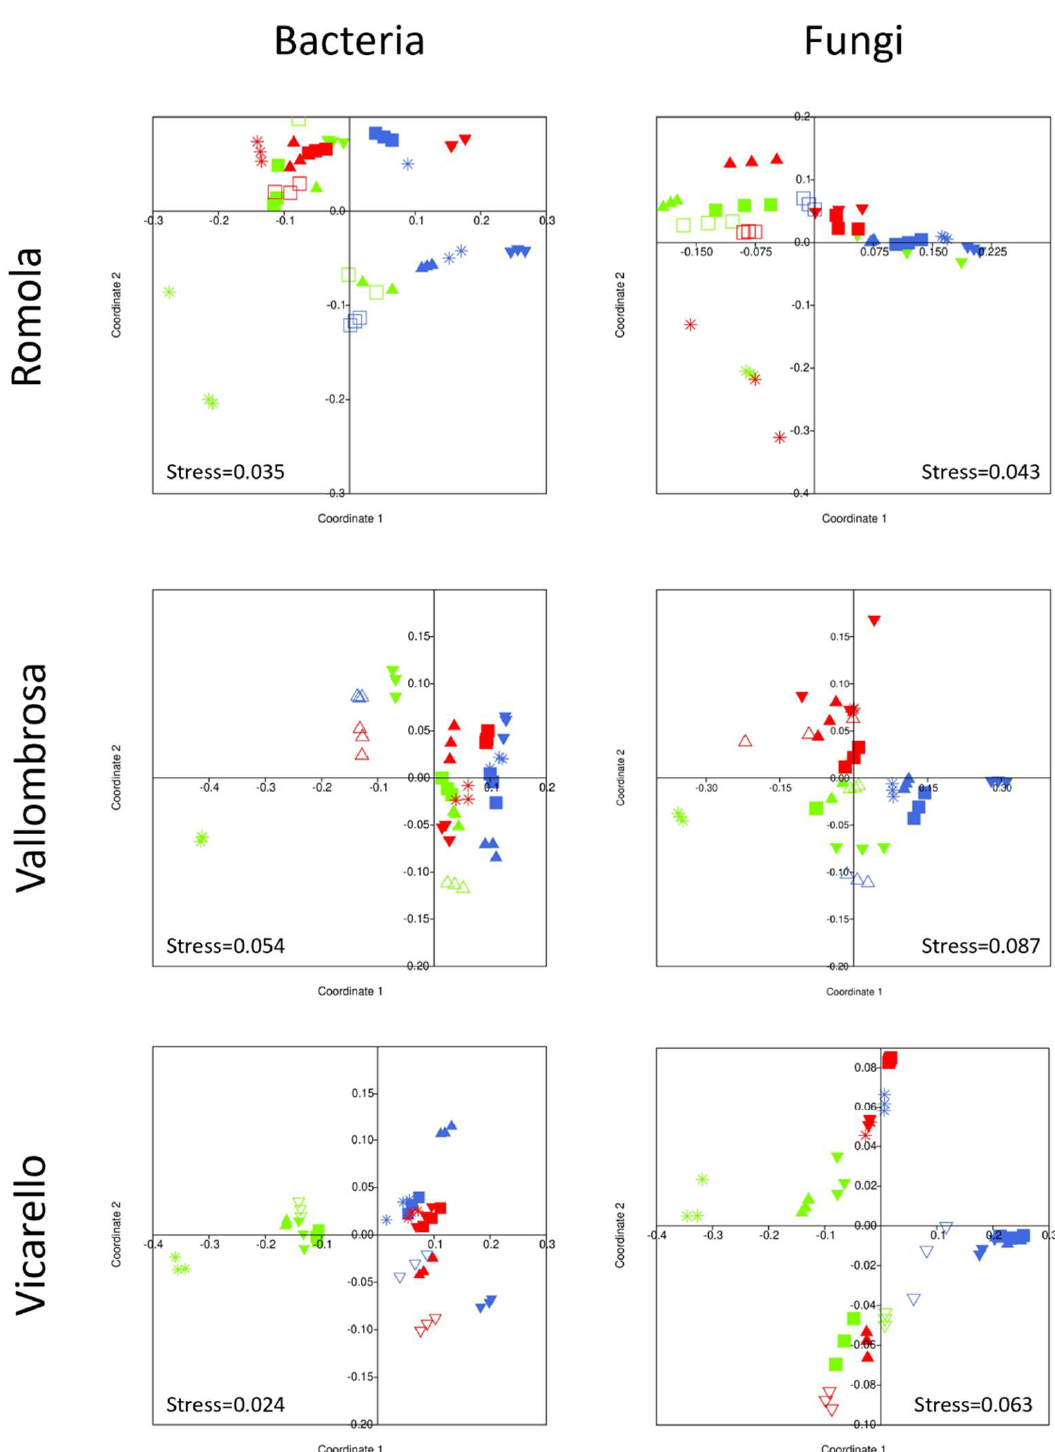
Figure 3. NMDS of the CLPP data obtained from the Biolog Ecoplates (bacteria) and FF plates (fungi) from Romola (square), Vallombrosa (triangle) and Vicarello (triangle) soils and sterilized soils (star) as well as self- or cross-reinoculated with Romola (filled square), Vallombrosa (filled triangle) and Vicarello (filled inverted triangle) soils after 1 day (green), 7 days (blue) and 30 days of incubation (red).